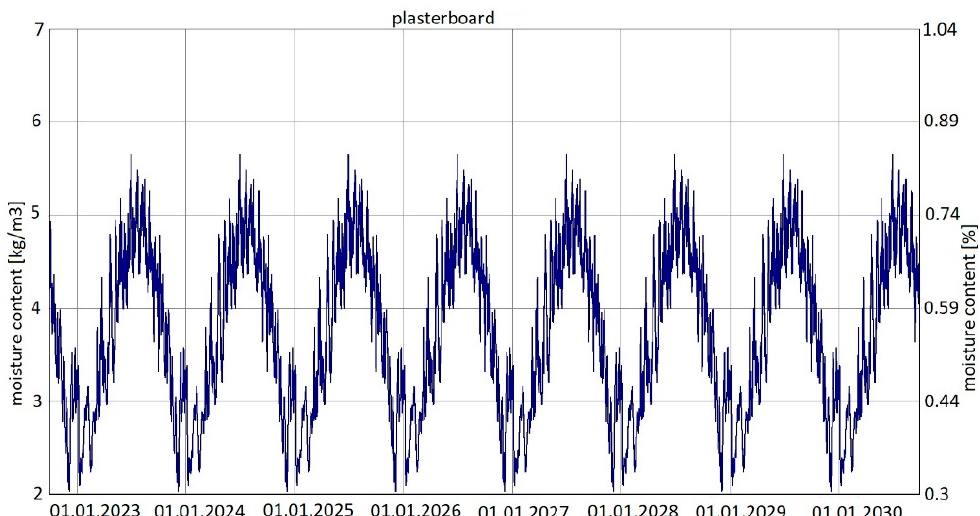
Figure 13. Changes in moisture content in plasterboard over eight years, variant 4 [70]. As previously, the isopleths of the LIM B I (dashed line) and LIM B II (solid line) curves, i.e., contour charts of the mould growth rate as a function of temperature (horizontal axis) and humidity (vertical axis) appearing in the diagram, do not intersect with the area of points for the analysed partition. Mould spots appeared at a minimum relative humidity of 30% and a temperature of 18 ◦ C. There is no critical value in the isopleth (Figure 14), i.e., no point where the curves intersect with the area of